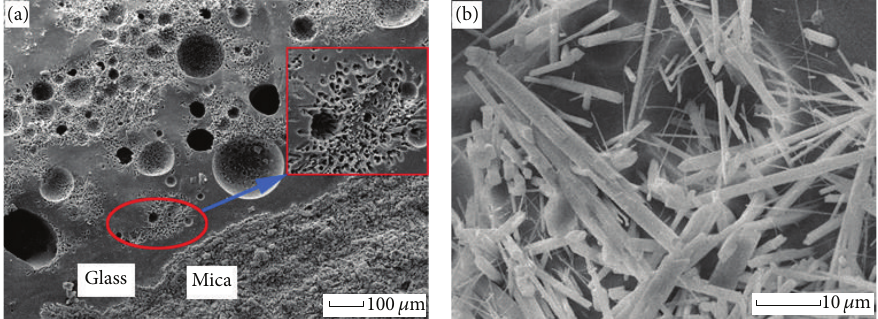
Figure 6: Microstructures of the interface in sandwich samples after hydrofluoric acid etching.